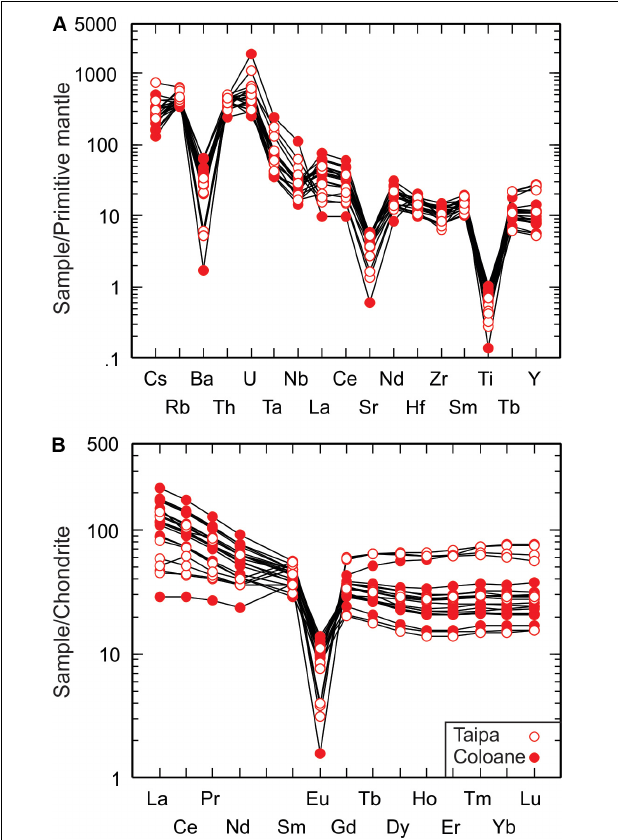
FIGURE 5 | (A) Primitive-mantle normalized incompatible element and (B) chondrite normalized rare earth element diagrams of the leucogranites from Taipa and Coloane. Rocks are normalized to values of Sun and McDonough (1989).